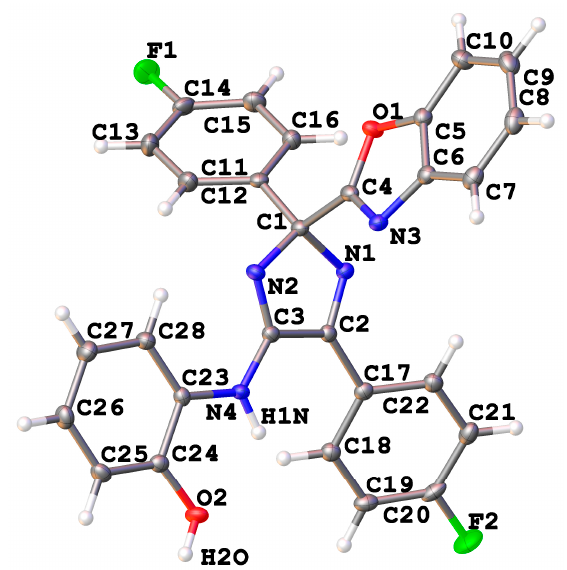
Figure3. Thegeneralviewof2-((2-(benzo[ d ]oxazol-2-yl)-2,5-bis(4-fluorophenyl)- 2H -imidazol-4-yl)amino)phenol Figure 3. The general view of 10b in representation of atoms by thermal ellipsoids ( p = 2-((2-(benzo[ d ]oxazol-2-yl)-2,5-bis(4-fluorophenyl)- 2H- imidazol-4-yl)amino)phenol 10b in representation of atoms by thermal ellipsoids ( p = 50%).